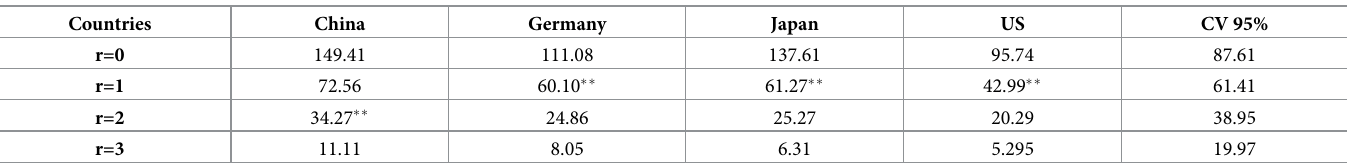
Table 9. Trace statistic test for Co-integration. Countries